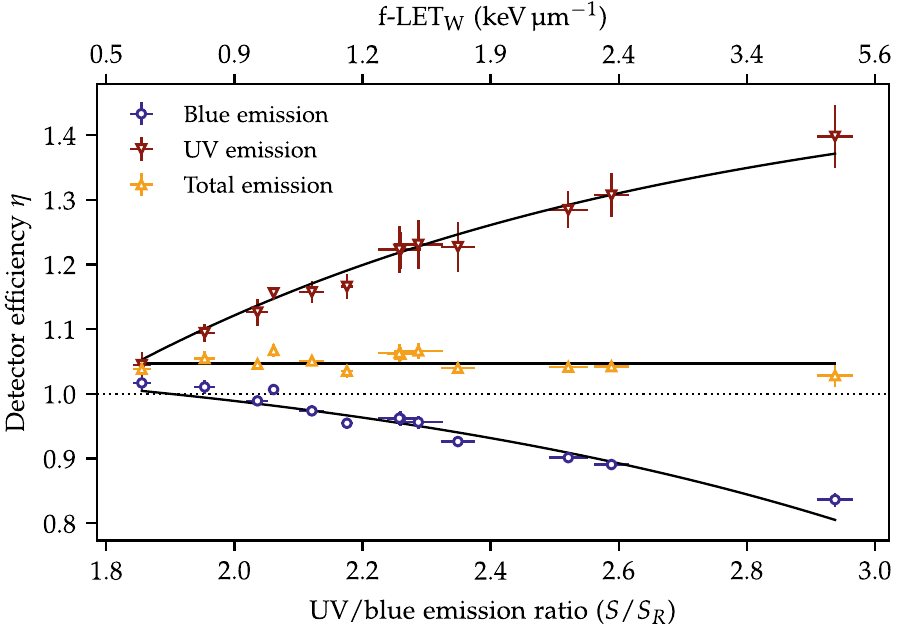
Figure 4. Relative luminescence efficiency for the Al 2 O 3 :C OSLD as a function of UV/blue ratio for the three quantities used for dose calculations. The LET values at certain points are shown for